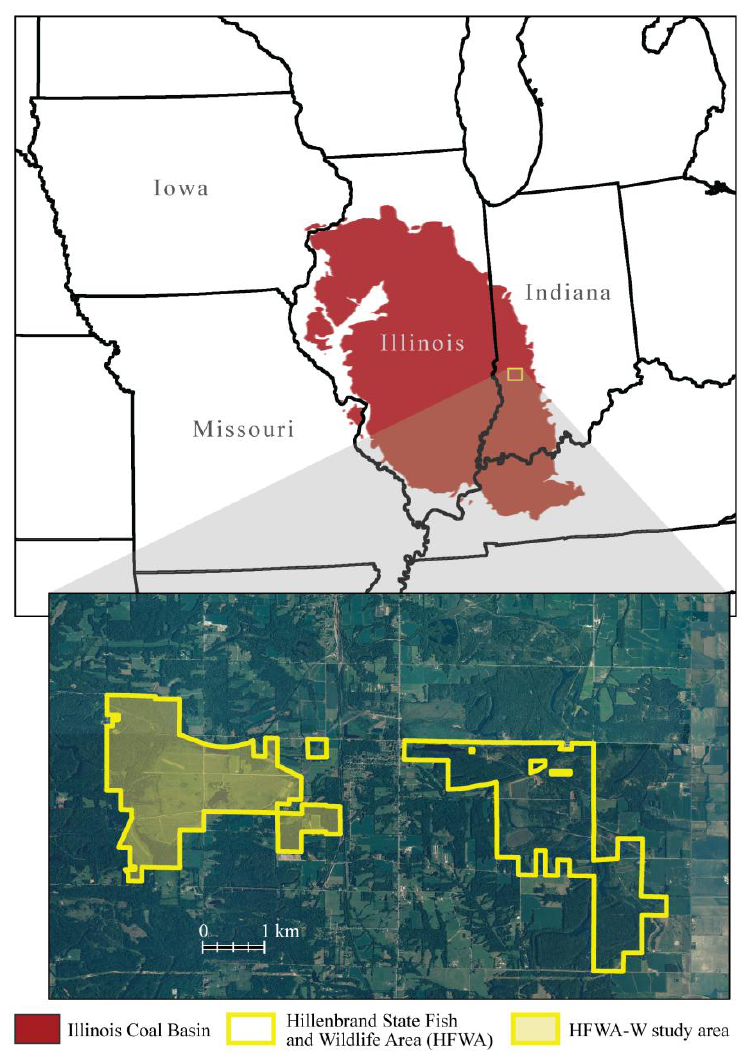
Figure 1. Extent of the coal fields in the Illinois Basin and the Hillenbrand study